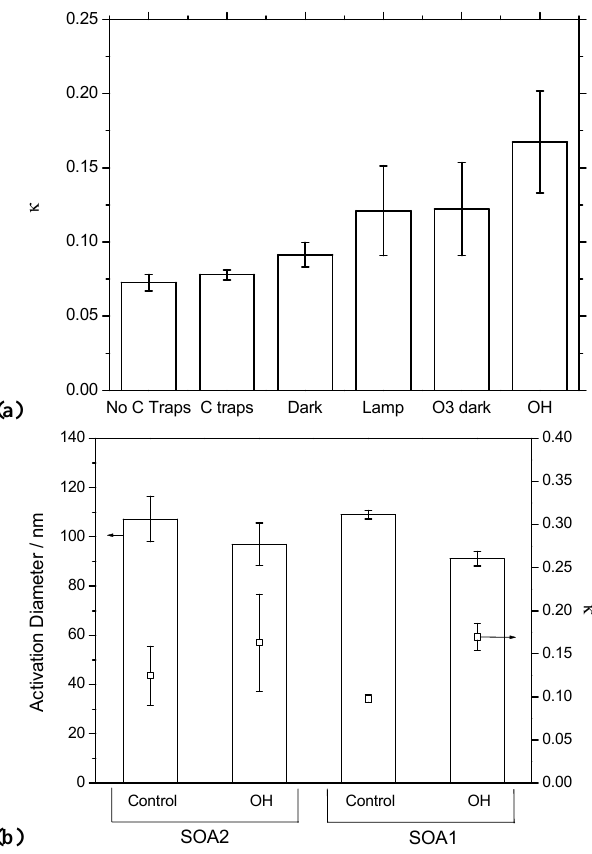
Fig. 9. (a) Average κ values for various flow tube control conditions and for an average OH exposure of 5.1 × 10 − 8 atm-s for the “OH” column. (b) Activation diameter (bars) and corresponding κ values (squares) of SOA2 and SOA1 for control conditions and for OH exposure conditions. CCN experiments were conducted under an effective supersaturation of S eff =0.32%. Error bars represent one standard deviation of mean